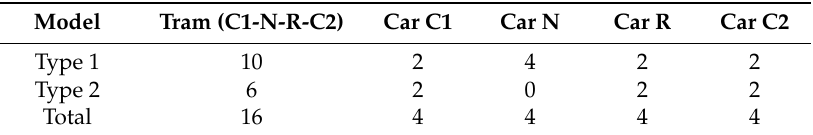
Table 1. Convector types in each car.